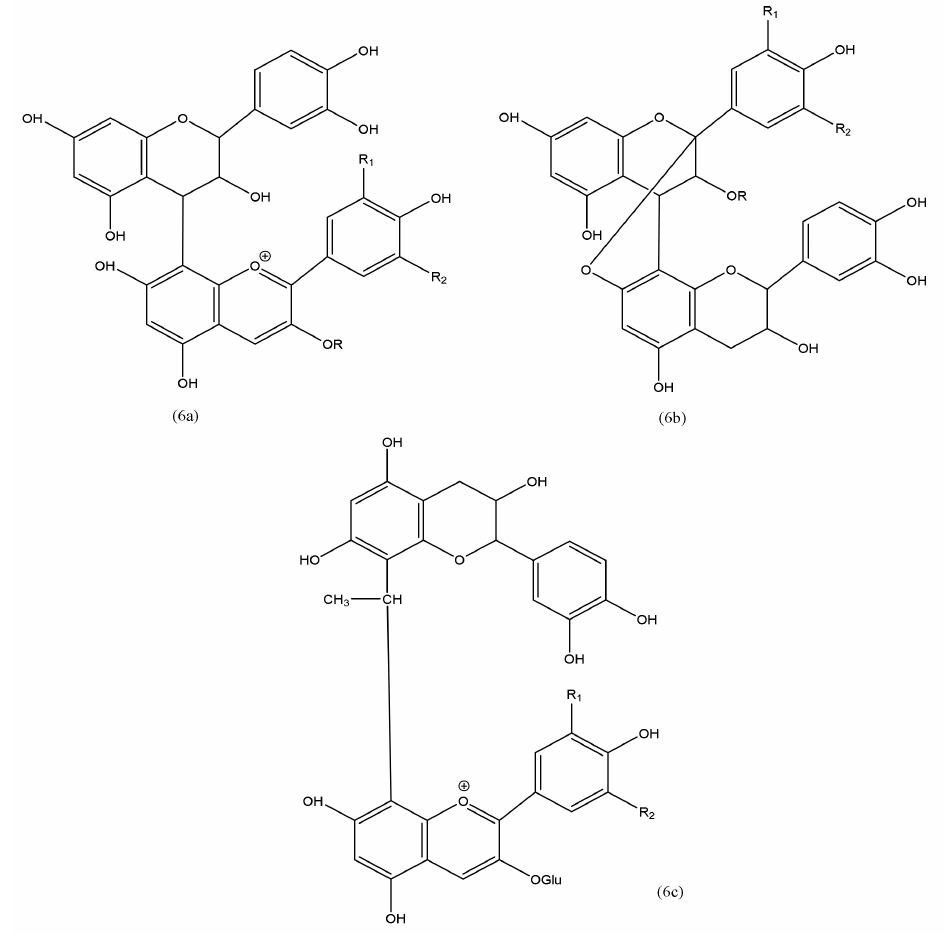
Figure 6. Derivative Flavanol-Anthocyanin ( 6a ), Anthocyanin-Flavanol ( 6b ) by direct condensation and condensation mediated by acetaldehyde ( 6c